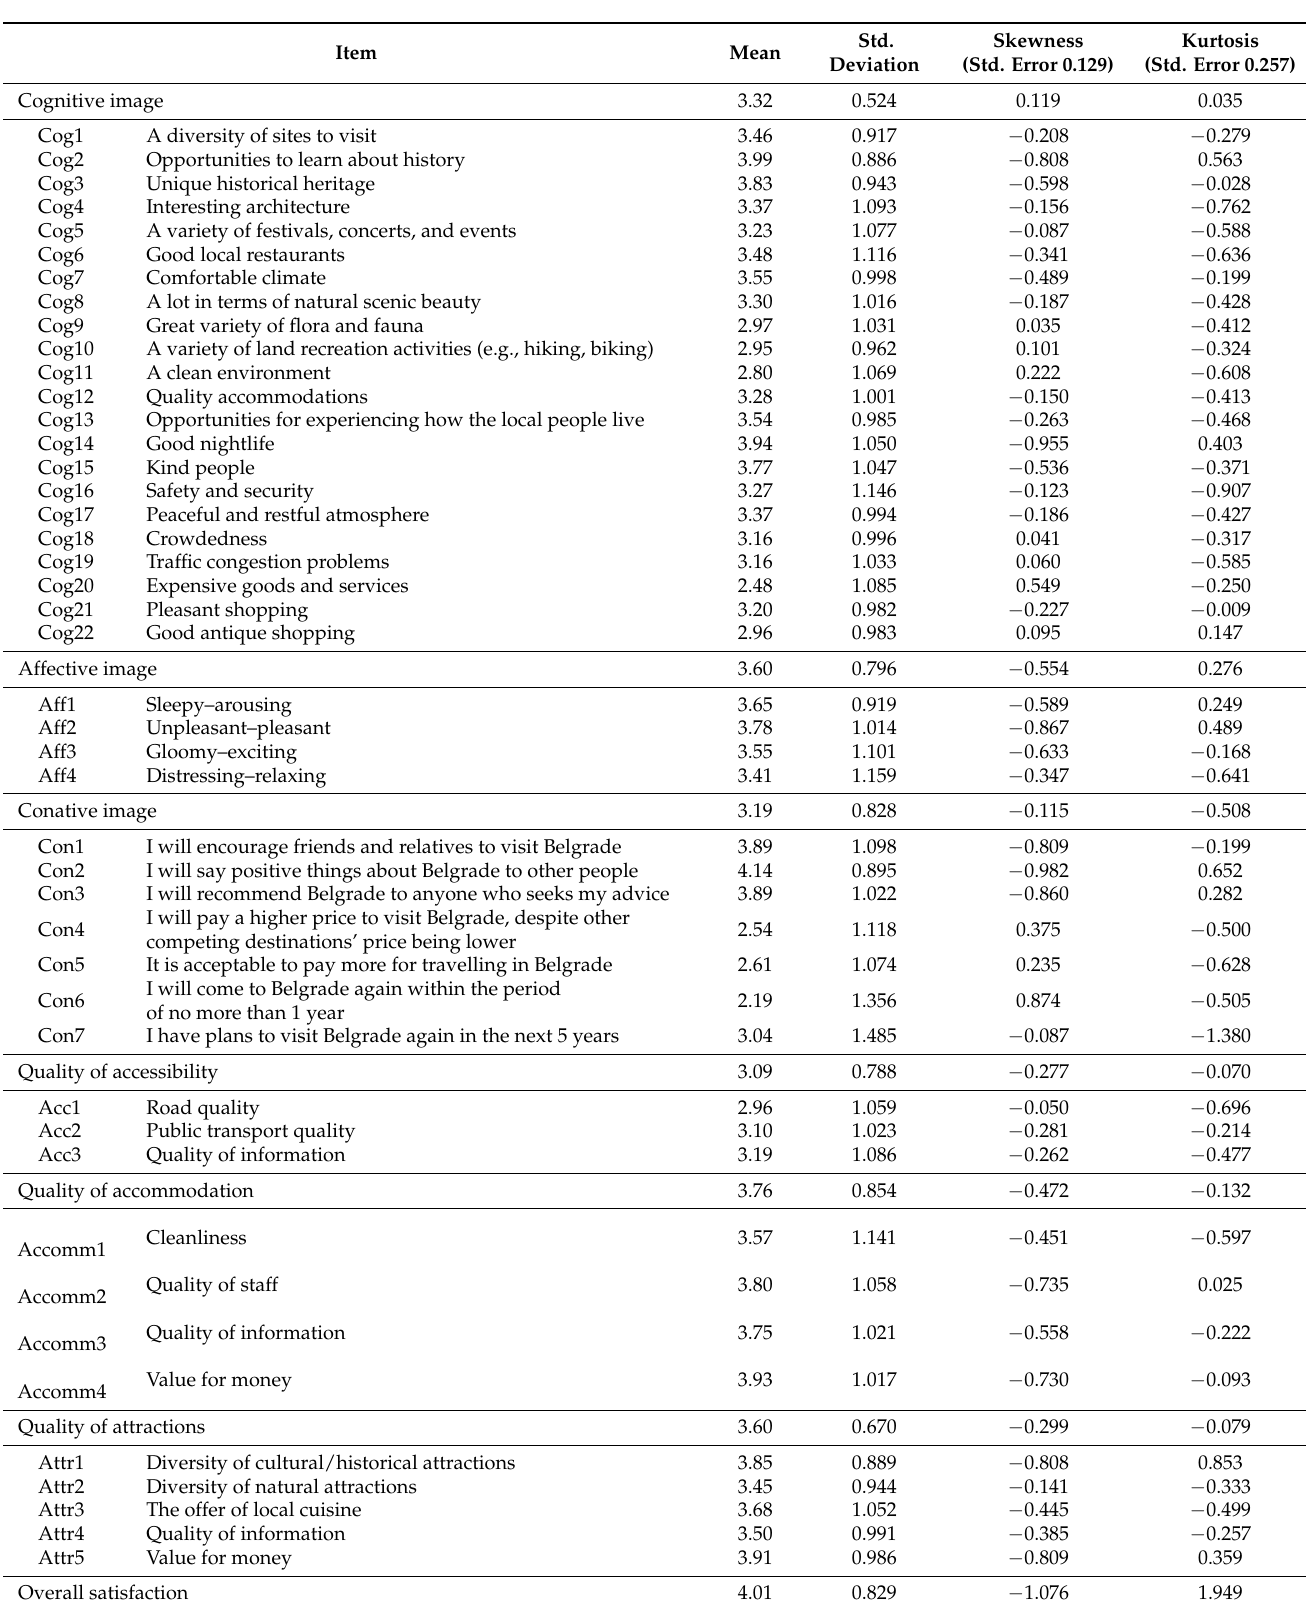
Table A6. List of constructs and items with means, standard deviations, skew, and kurtosis (n =